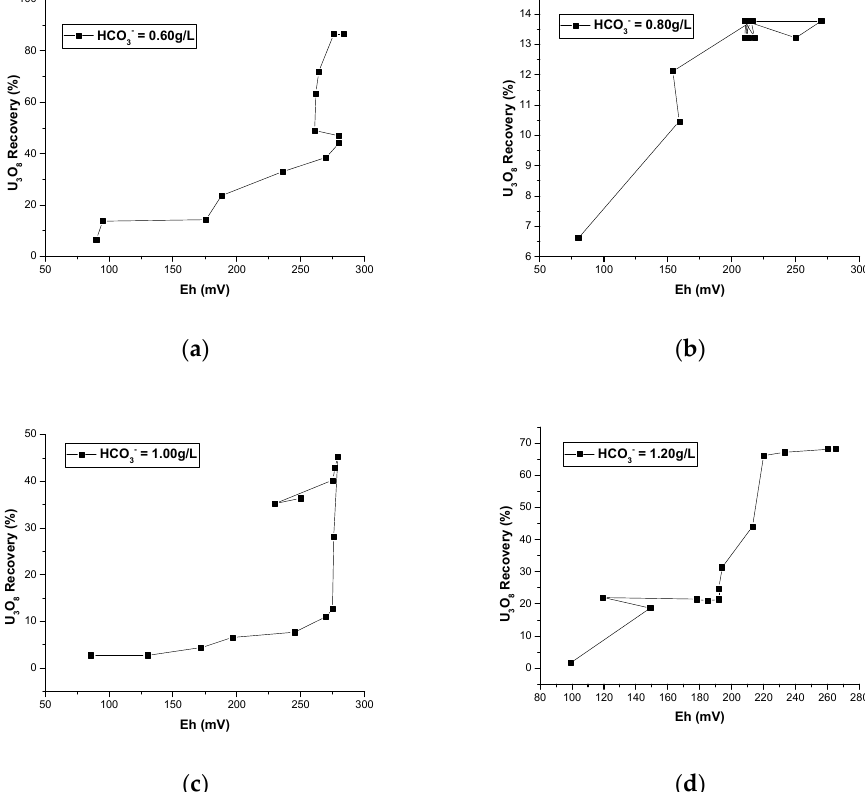
Figure 12. Uranium recovery and Eh variations in leaching solution with different HCO 3 − concentrations: ( a ) 0.60g/L; ( b ) 0.80g/L; ( c ) 1.00g/L; ( d ) 1.20g/L).